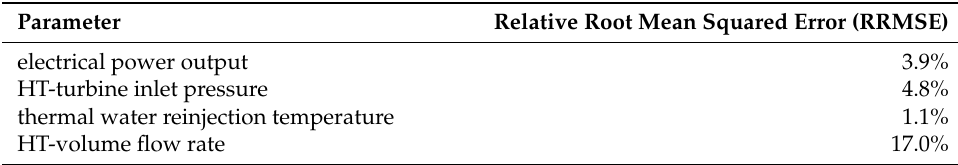
Table 4. Validation results of the considered power